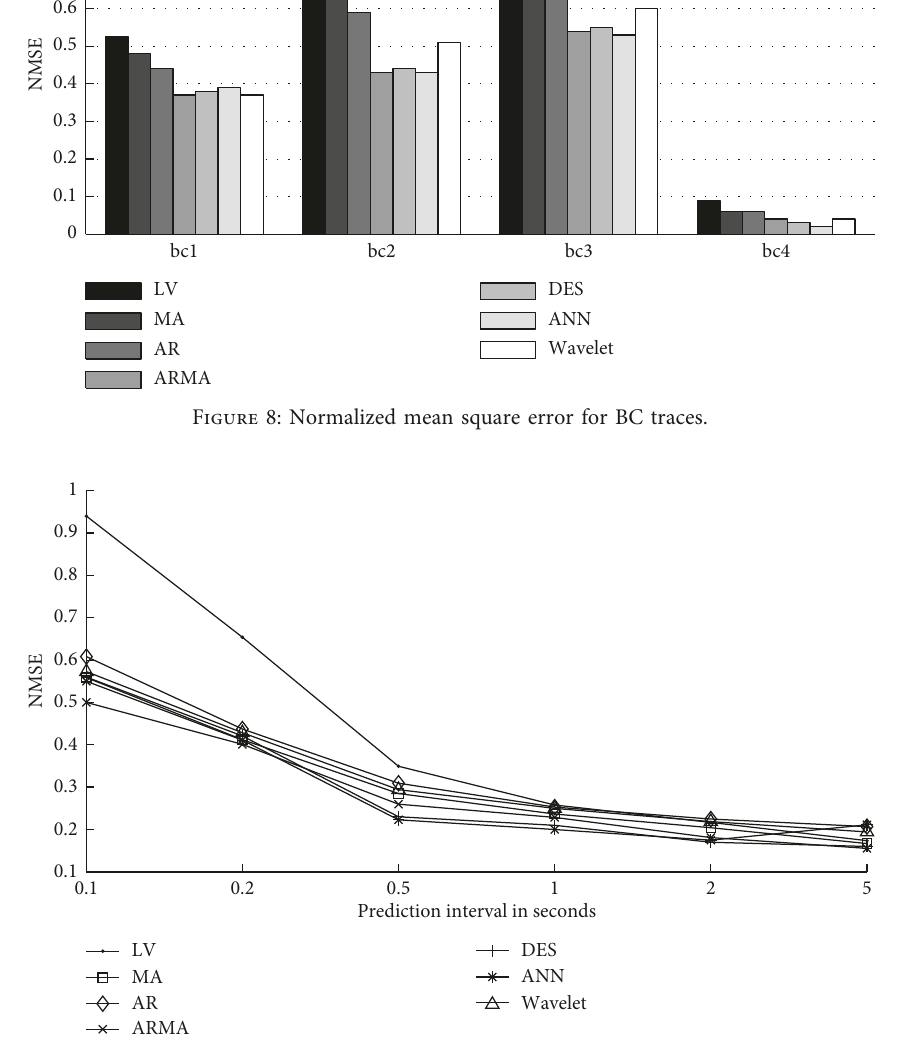
Figure 9: Effect of increasing prediction interval on the performance of predictors. Table 2: Processor configuration used to measure energy con- sumed by